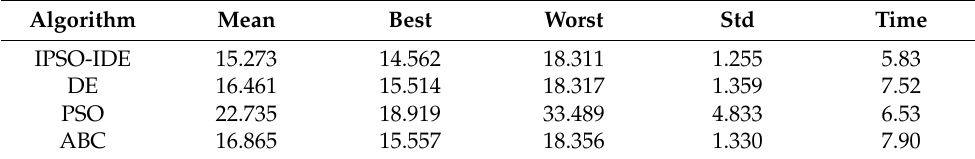
Table 6. Path planning results of different algorithms in environment 3.